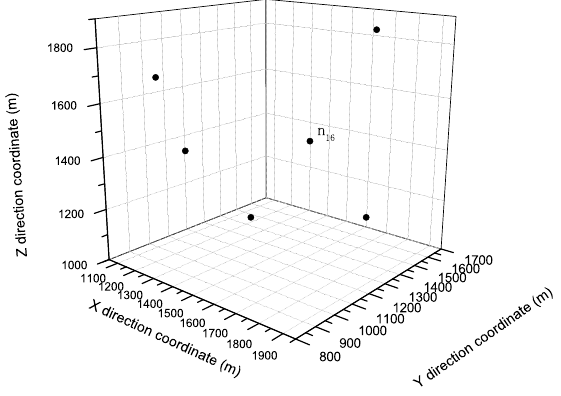
Fig.2. Node n 16 and its neighbors’ three-dimensional coordinates.